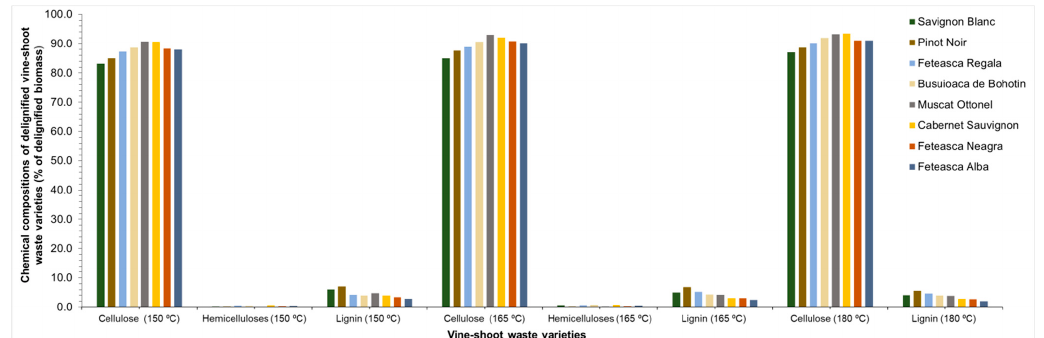
Figure 5. Chemical compositions of residual solids after delignification of pretreated shoot wastes of the studied vine plant varieties.